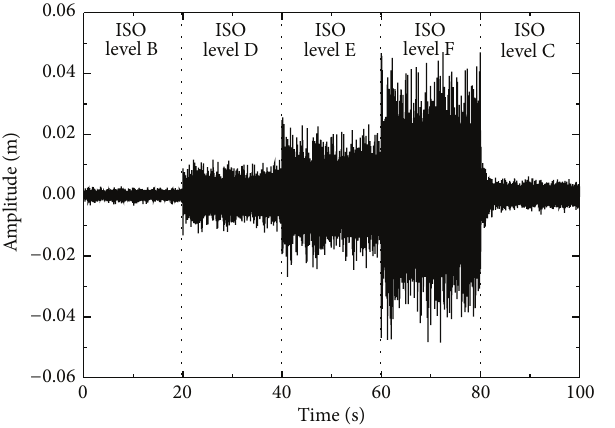
Figure 7: Detail components for estimated road profile. (2) The road level remains unchanged within every 20 seconds.